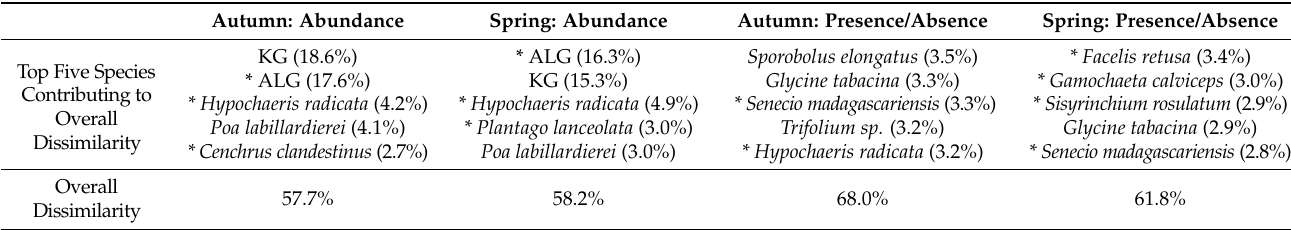
Figure 4. nMDS with input data based on ( a ) the abundance and ( b ) presence/absence of plant species using both spring and autumn data in each graph. Each farm is illustrated with a different colour, whereas each polygon represents a site, and the lines connect the centroids of the KG (triangle) and the corresponding ALG+KG (circle) site of the same farm. A black line around the centroid symbols represents the spring data, whereas its absence stands for the autumn data. The letters S and N in the farm name represent the southern group (S) and the northern group (N) of farms. Table 2. Output of SIMPER showing the five most discriminating species (contribution to overall dissimilarity [%] whereby overall dissimilarity = 100%) among KG and ALG+KG sites. A * in front of the species name indicates its non-native origin. Overall dissimilarity for each season and model (abundance and presence/absence) is given in the last row. For full species lists, please see Supplementary Tables